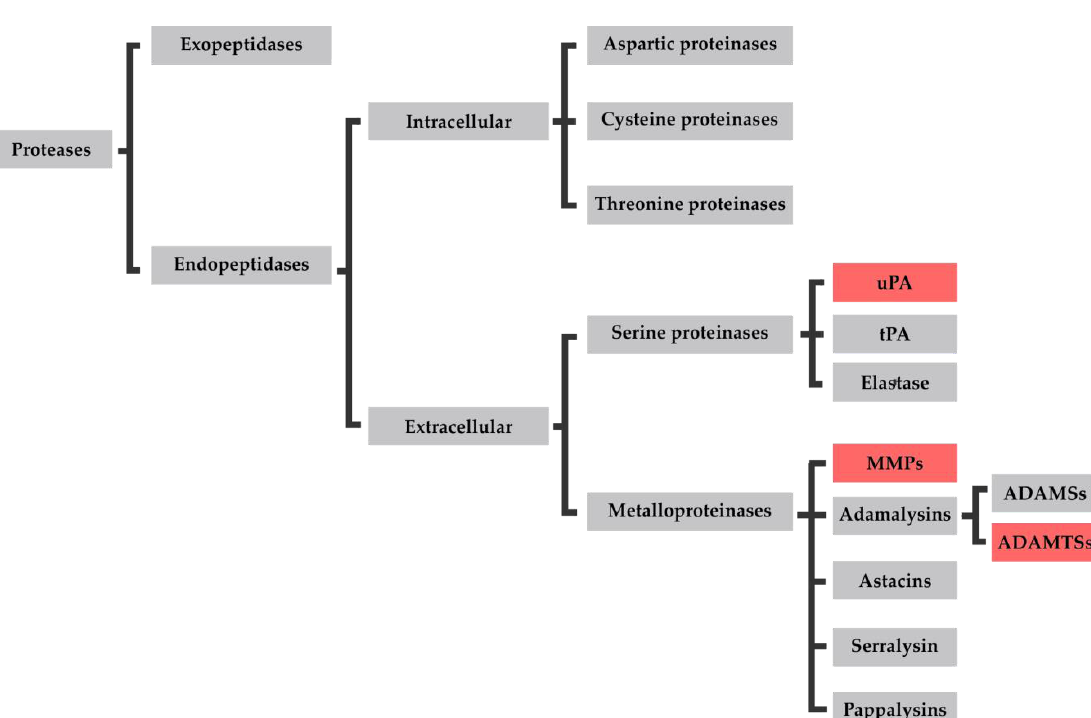
Scheme 1. Classification of proteases. Families of proteases involved in osteoarthritis (OA) development are highlighted in red, adapted from [55,56].